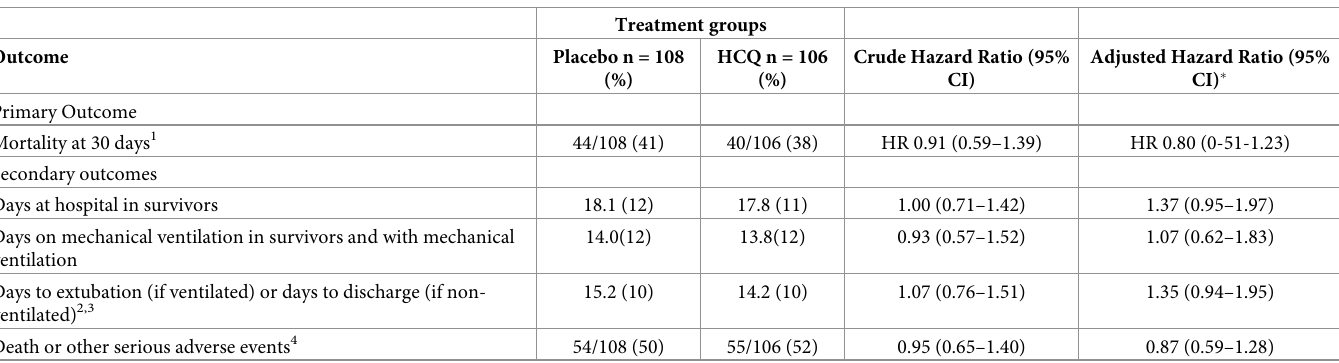
Table 3. Outcomes of the trial n/total patients (%) or means (SD).